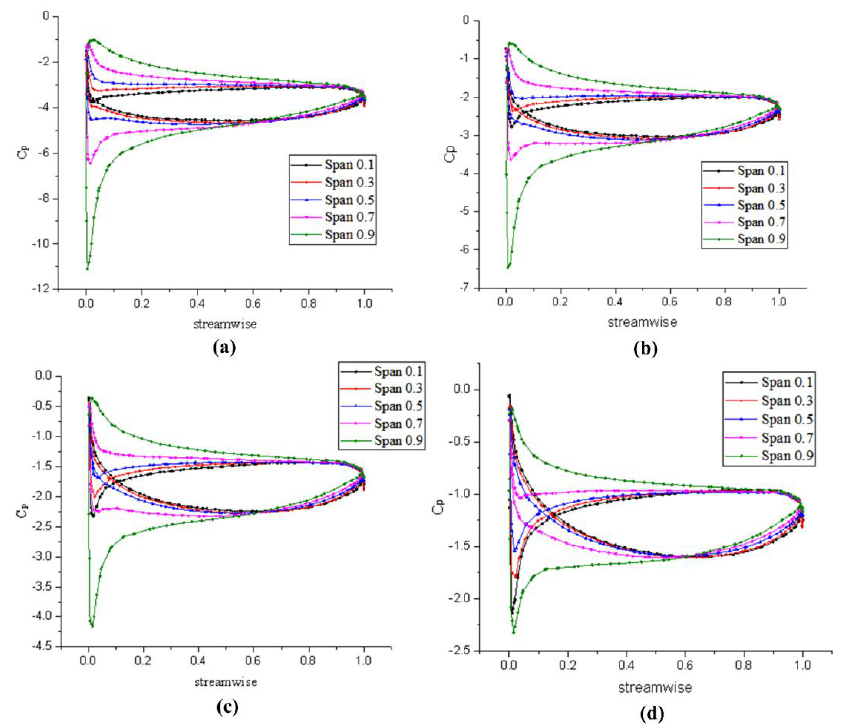
Figure 18. Tangential pressure distribution of stator matched with lifting method: ( a ) v = 7 m/s ( J = 0.78), ( b ) v = 8.5 m/s ( J = 0.95), ( c ) v = 10 m/s ( J = 1.12), and ( d ) v = 11.5 m/s ( J = 1.28).